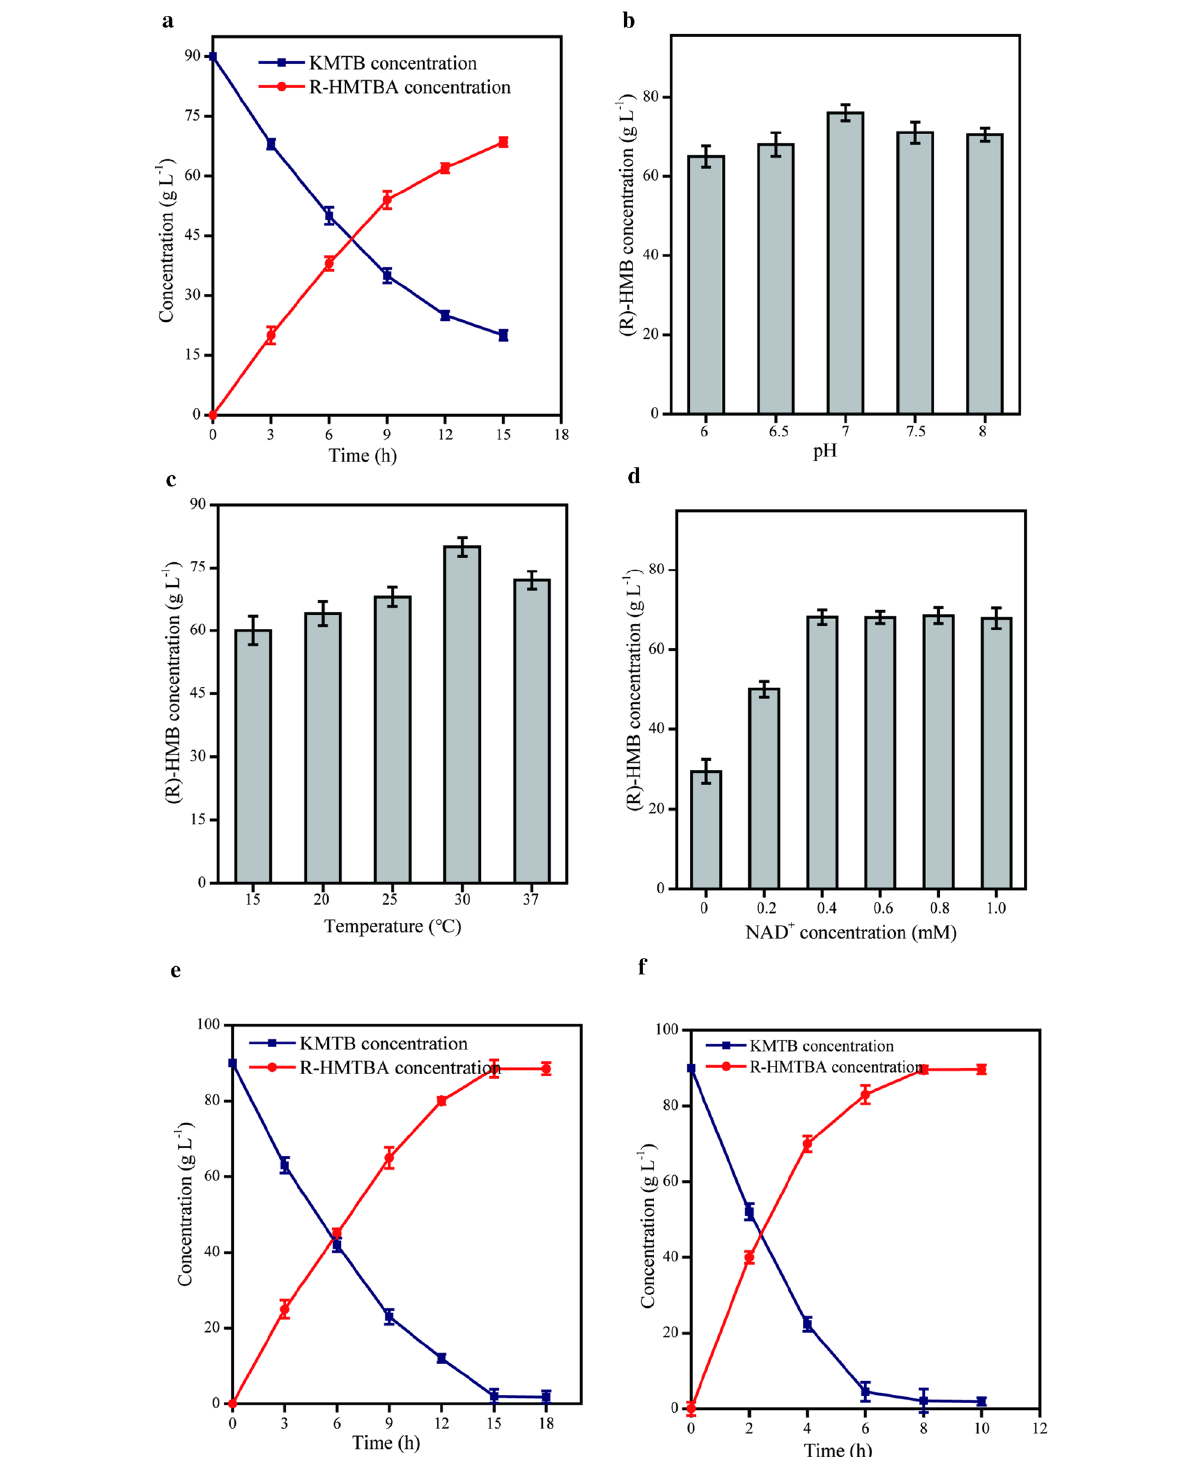
Fig. 3 Optimization of EM1. a Time courses of the initial conditions: wet biomass of R-selective whole-cell catalyst (20 g L − 1 ) in KP buffer (50 mM, pH 6.5, 1 mM NAD + ) containing the KMTB (90 g L − 1 ) and sodium formate (125 g L − 1 ), at 200 rpm and 25 °C. b Effects of different pH on ( R )-HMTBA production. c Effects of different temperatures on ( R )-HMTBA production. d Effects of NAD + concentration on ( R )-HMTBA production. e Time course of the optimized conditions: wet biomass of R-selective whole-cell catalyst (20 g L − 1 ) in KP buffer (50 mM, pH 7.0, 0.4 mM NAD + ) containing the KMTB (90 g L − 1 ) and sodium formate (125 g L − 1 ), at 200 rpm and 30 °C at 20-mL scale. f Time course of the optimized conditions at 1-L